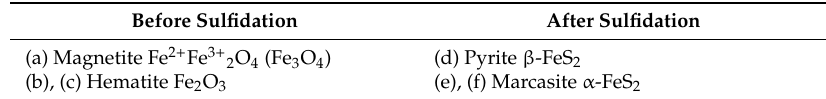
Figure 5. Raman spectra of iron oxide films before sulfidation, (a), (b) and (c) ( left ). Samples after sulfidation, (d), (e) and (f) ( right ). Amplitudes of measured spectra are scaled for better visibility. Table 2. Dominating phases identified in spectra of Figure 5 using the Raman spectra database RRUFF [16].